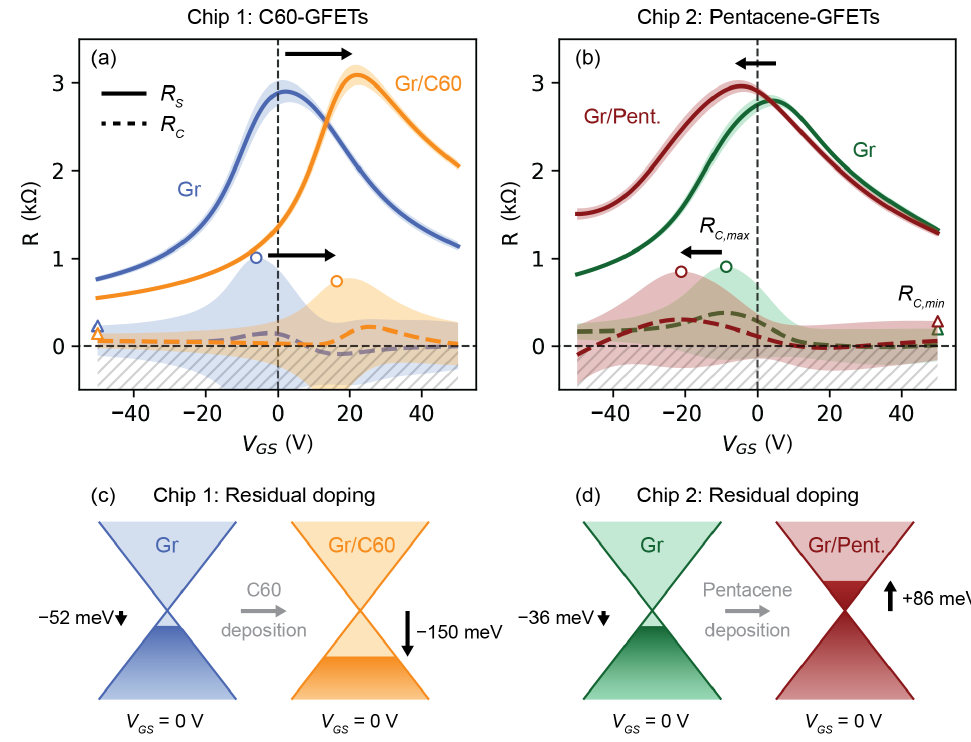
Figure 4. GFETs’ sheet resistance ( R S ) and contact resistance ( R C ) represented by solid and dashed lines, respectively. ( a ) R S (solid line) and R C (dashed line) of pristine CVD graphene before (blue) and after (orange) deposition of C60 (Chip 1). The circles and triangles show the maxima and minima of the contact resistance, respectively. The arrows show the shift of the maximum of R S and of the maximum of R C due to the deposition of the molecules. ( b ) R S (solid line) and R C (dashed line) of pristine CVD graphene before (green) and after (red) deposition of Pentacene (Chip 2). The shaded areas are the standard errors of the estimated slope and intercept of the linear regression method used to extrapolate 𝑅 (cid:3020) and 𝑅 (cid:3004) with the Transfer Length Method (TLM) from the datasets presented in Figure 3a–d. ( c ) Schematic of the residual p-doping of graphene due to C60 deposition (Chip 1). ( d ) Schematic of the residual n-doping of graphene due to Pentacene deposition (Chip 2). Table 1. Summary of the electrical properties of the GFETs before and after deposition of the C60 and Pentacene molecules. The table shows the mean and variance of the normal distributions of 𝑉 (cid:3008)(cid:3020)(cid:3005)(cid:3036)(cid:3045)(cid:3028)(cid:3030) , 𝜇 (cid:3032) and 𝜇 (cid:3035) in Figure 3e–j. The residual doping of graphene is calculated considering the mean and variance values of 𝑉 (cid:3008)(cid:3020)(cid:3005)(cid:3036)(cid:3045)(cid:3028)(cid:3030) in Equation (1) before and after deposition of the molecules. The Fermi energy shift 𝛥𝐸 (cid:3007) is calculated using the energy dispersion relation of graphene and re- sidual doping. The table shows the minimum and maximum values of the gate-dependent sheet resistance ( 𝑅 (cid:3020) ) and contact resistance ( 𝑅 (cid:3004) ) presented in Figure 4. The contact resistivity 𝜌 (cid:3004) = 𝑅 (cid:3004) 𝑊 is calculated using the channel width W = 5 µm.